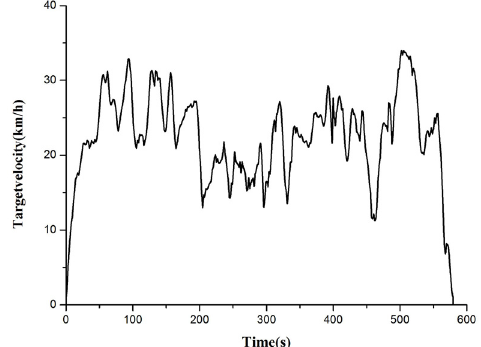
Figure 6. Smooth driving cycle (road grade-distance).